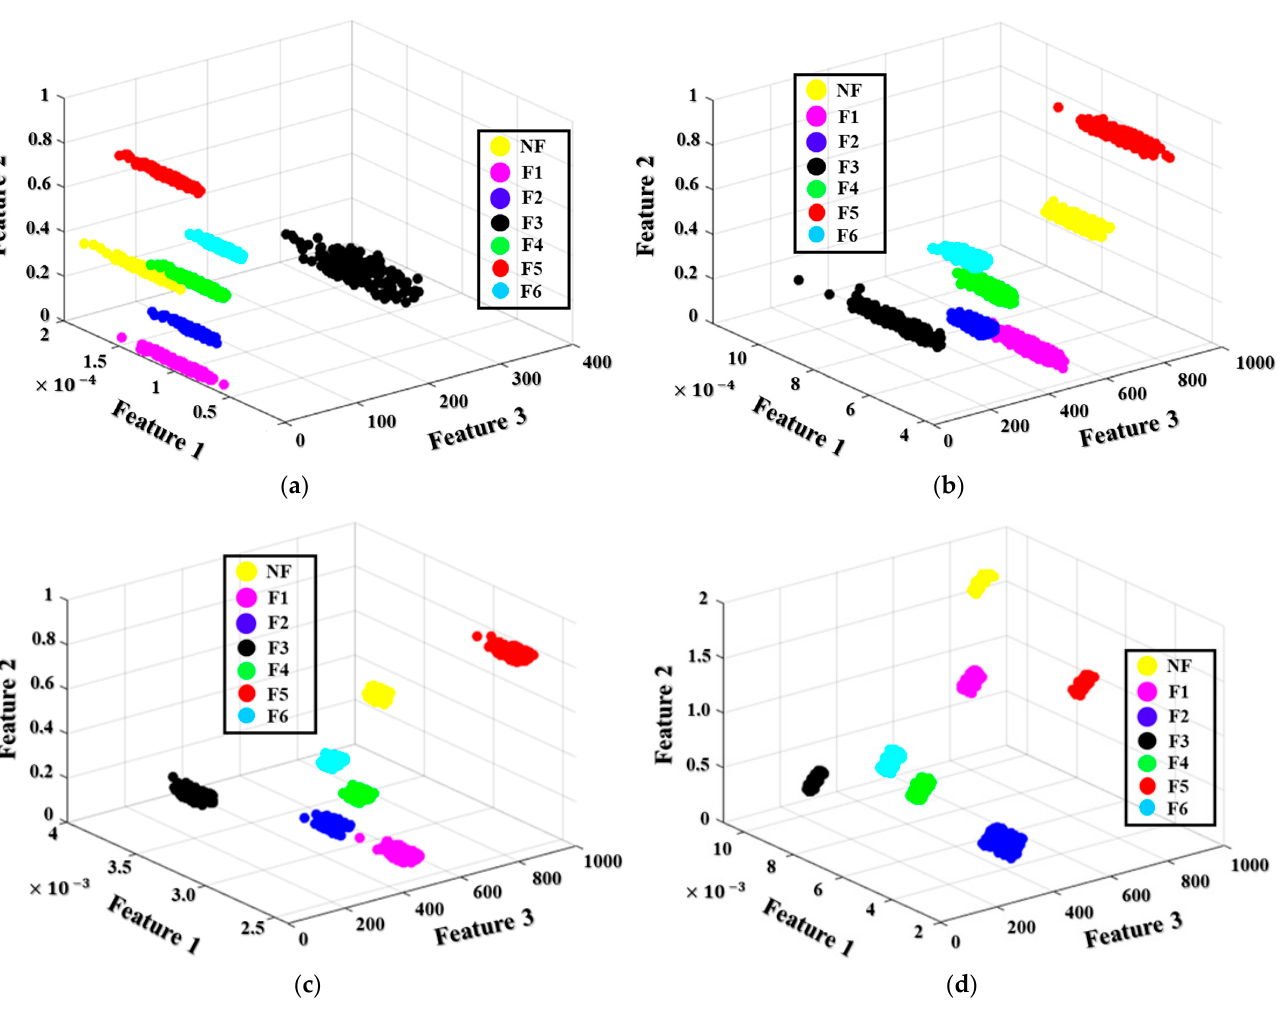
Figure 9. Three-dimensional visualization of samples of the seven failure types under four rotational speeds: ( a ) 300 RPM, ( b ) 600 RPM, ( c ) 900 RPM, and ( d ) 1200 RPM. speeds: ( a ) 300 RPM, ( b ) 600 RPM, ( c ) 900 RPM, and ( d ) 1200